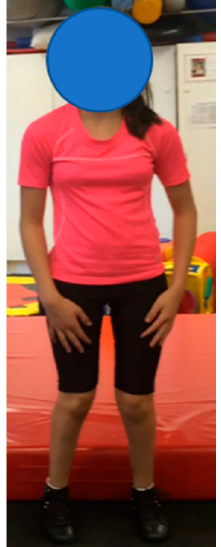
Table 5. Participant 4 outcome measure comparative results between SMotO and